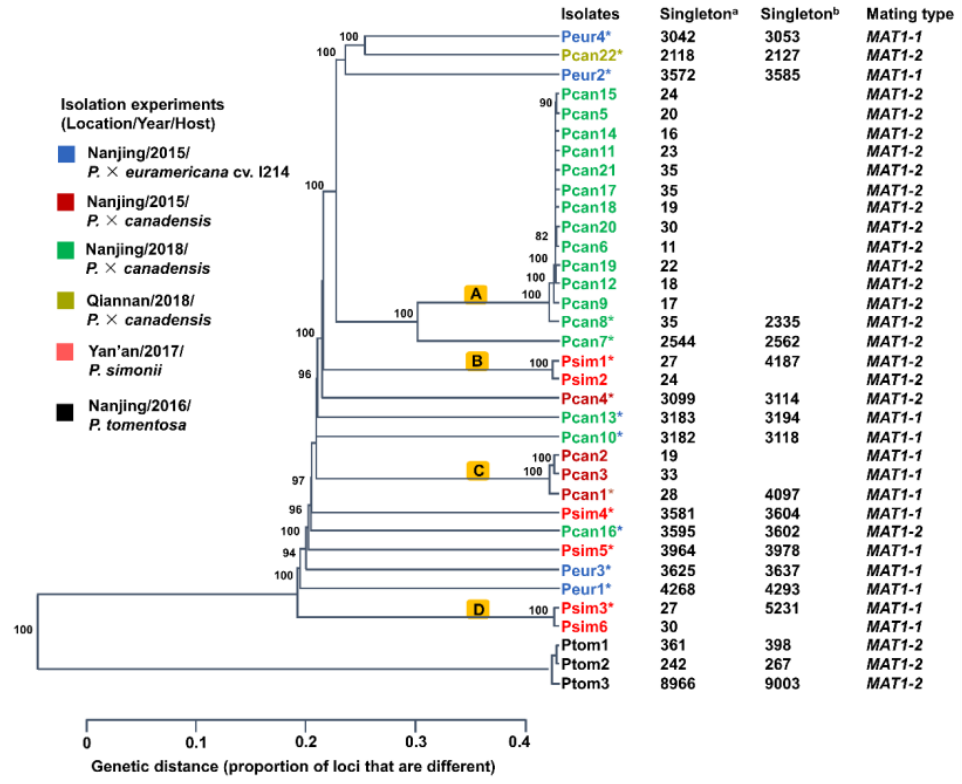
Figure 1. Phylogenetic analysis of 35 M . brunnea isolates. The UPGMA tree was inferred by Poppr with 1000 bootstrap replicates. Different isolation experiments are labeled in different colors. Pcan, P . canadensis of sect. Aigeiros; Peur, P . × euramericana cv. I214 of sect. Aigeiros; Psim, P . simonii of sect. Tacamahaca; Ptom, P . tomentosa of sect. Leuce; Nanjing, 118°77′ E, 32°04′ N; Yan’an, 109°28′ E, 36 ◦ 36 (cid:48) N; Qiannan, 107 ◦ 47 (cid:48) E, 27 ◦ 07 (cid:48) N; Singleton a , singletons identified in the SNP dataset of